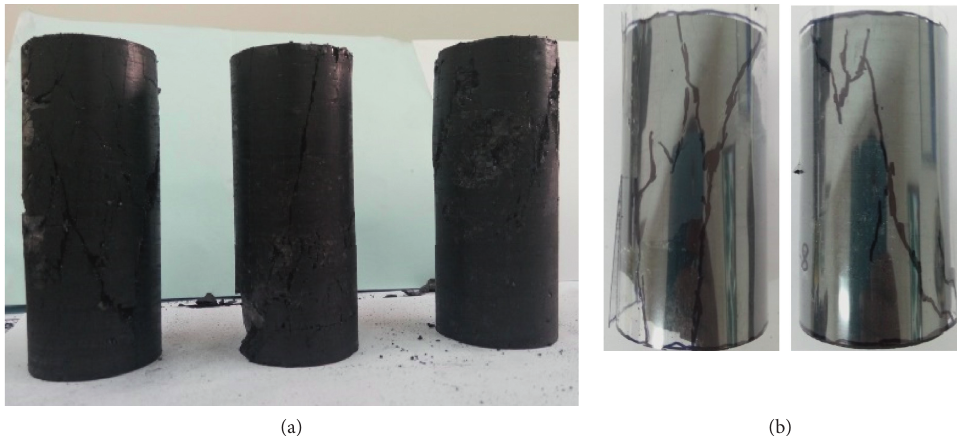
Figure 4: Rock samples with surface cracks after tests.